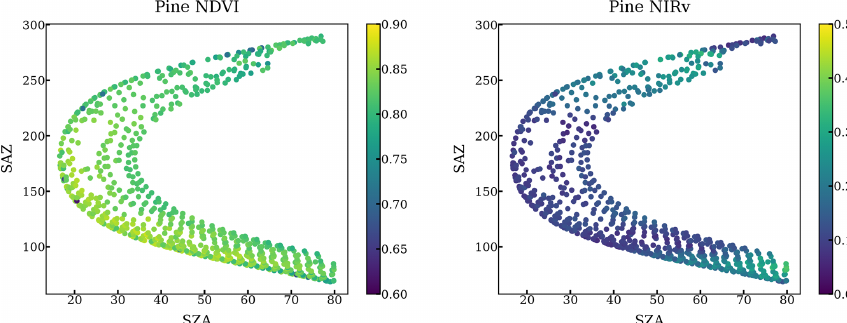
Figure A1. NDVI and NIRv of all scans targeting a pine at different solar azimuth angles and solar zenith angles throughout a year.